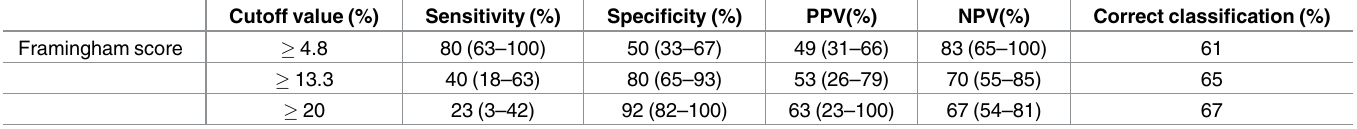
Table 2. Classification of Spanish patients with HS at Framingham risk equation cutoff values based on sensitivity or specificity set at 80% in ROC analysis, or conventional recommendations. Cutoff value